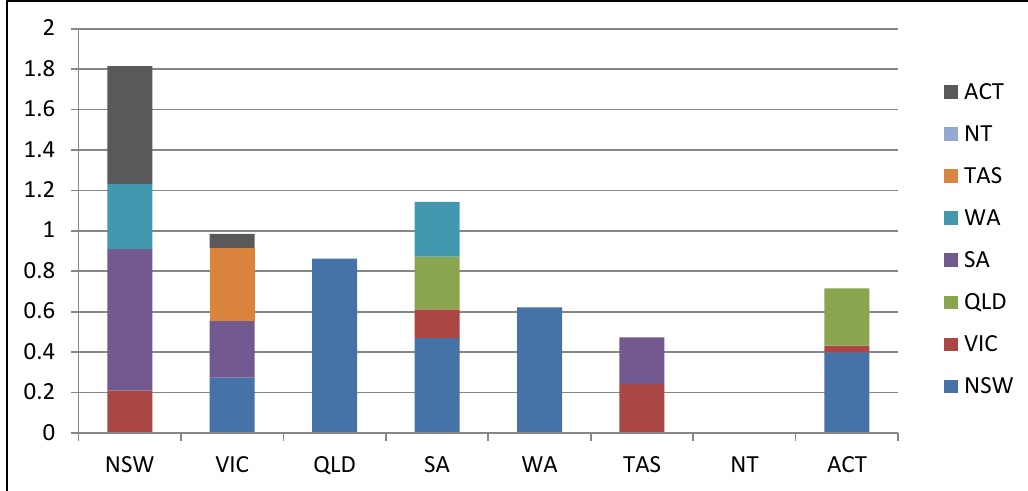
Figure 3 The short term inputs to changes of construction prices in each regional market The results of our spatial convergence tests suggest that there are 14 pairs of regional market with bidirectional causalities and other 5 pairs of regional markets with one-way causality only with other regional markets. It is also found that each market has at least one one-way causality with other regional markets except Northern Territory, and the causality links between the states are mainly with adjoining states. Furthermore, there are no causal relationships with the Northern Territory meaning that movements of construction prices in the Northern Territory do not affect other regions. This may be because the construction market in Northern Territory is the smallest of the eight regional markets. The construction price in New South Wales has the highest degree of positive influences on five regional markets may be because New Sales Wales in the last two decade has become the largest construction market in Australia. These results further pre sent evidence on “ripple effect” in the construction prices in Australian regional markets and that the changes in regional construction prices will positively influence neighbouring states first, and then spread out into other regions. Finally the regional prices converge and reach a long-run equilibrium in the following